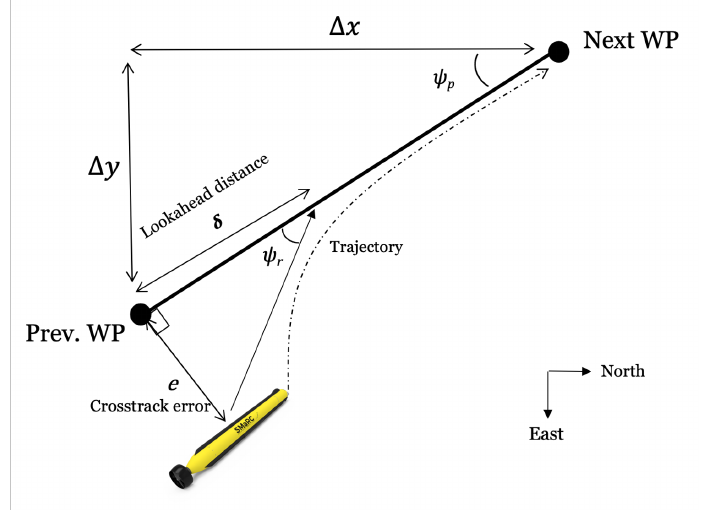
Figure 10. The line-of-sight guidance law considers a lookahead distance δ , the crosstrack error e , and the intercepts between waypoints ∆ y and ∆ x . This ensures the AUV follows the straight line between waypoints as much as possible by minimizing cross-track